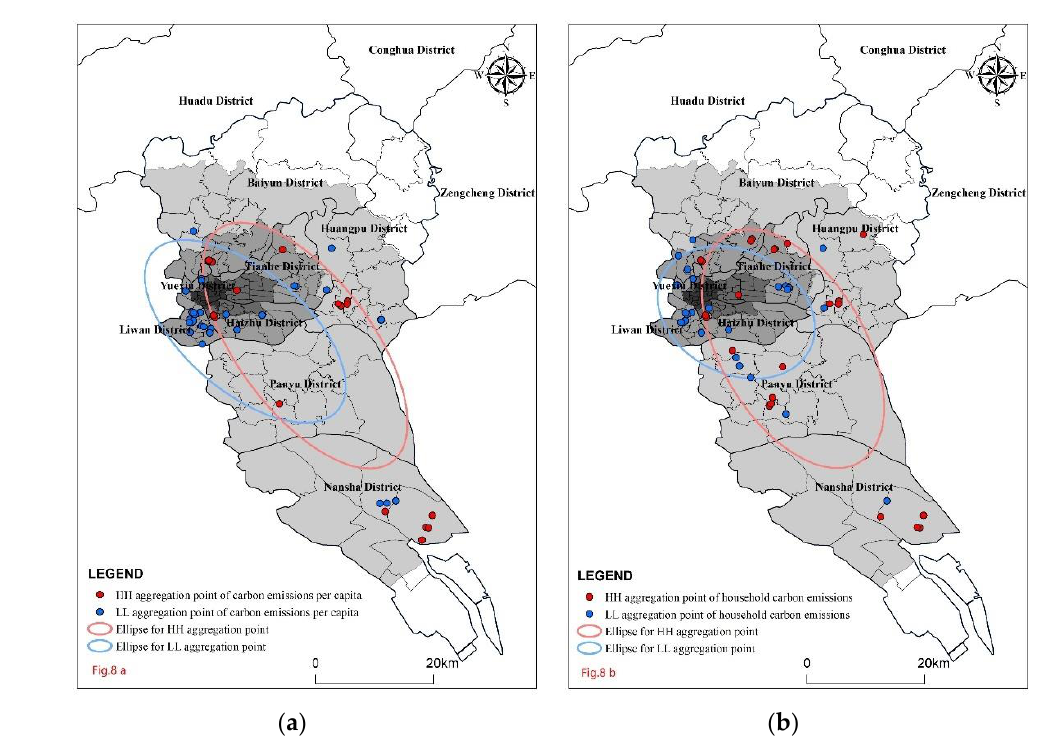
Figure 8. The SDEs of carbon emissions in Guangzhou. ( a ) The standard deviation ellipses (SDEs) per capita. ( b ) The SDEs of carbon emissions household carbon emissions.